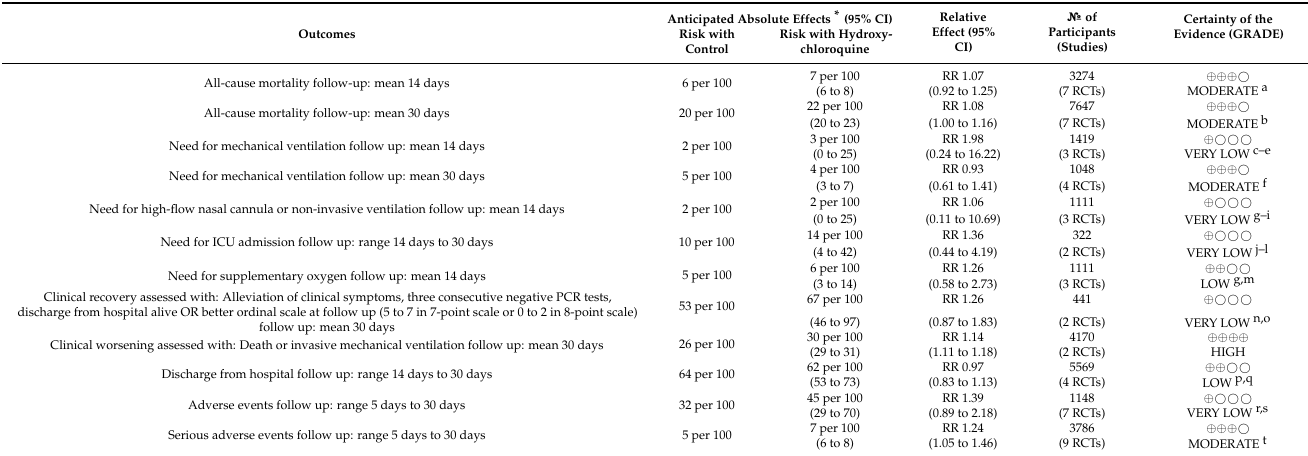
Summary of findings (SoF) table of the effects of hydroxychloroquine on outcomes of hospitalized COVID-19